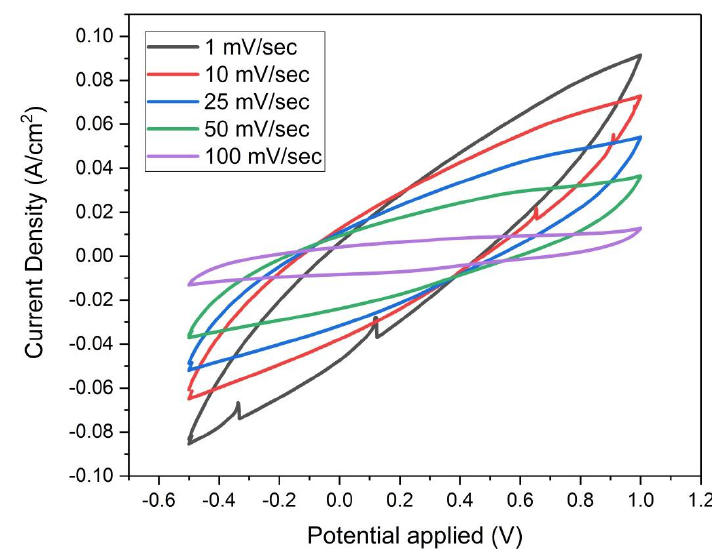
Figure 15. Cyclic Voltammograms of sample (F) at scan rates (1, 10, 25, 50 and 100 mV/sec), based on three-electrode measurement with 2 Molar H 2 SO 4 solution.